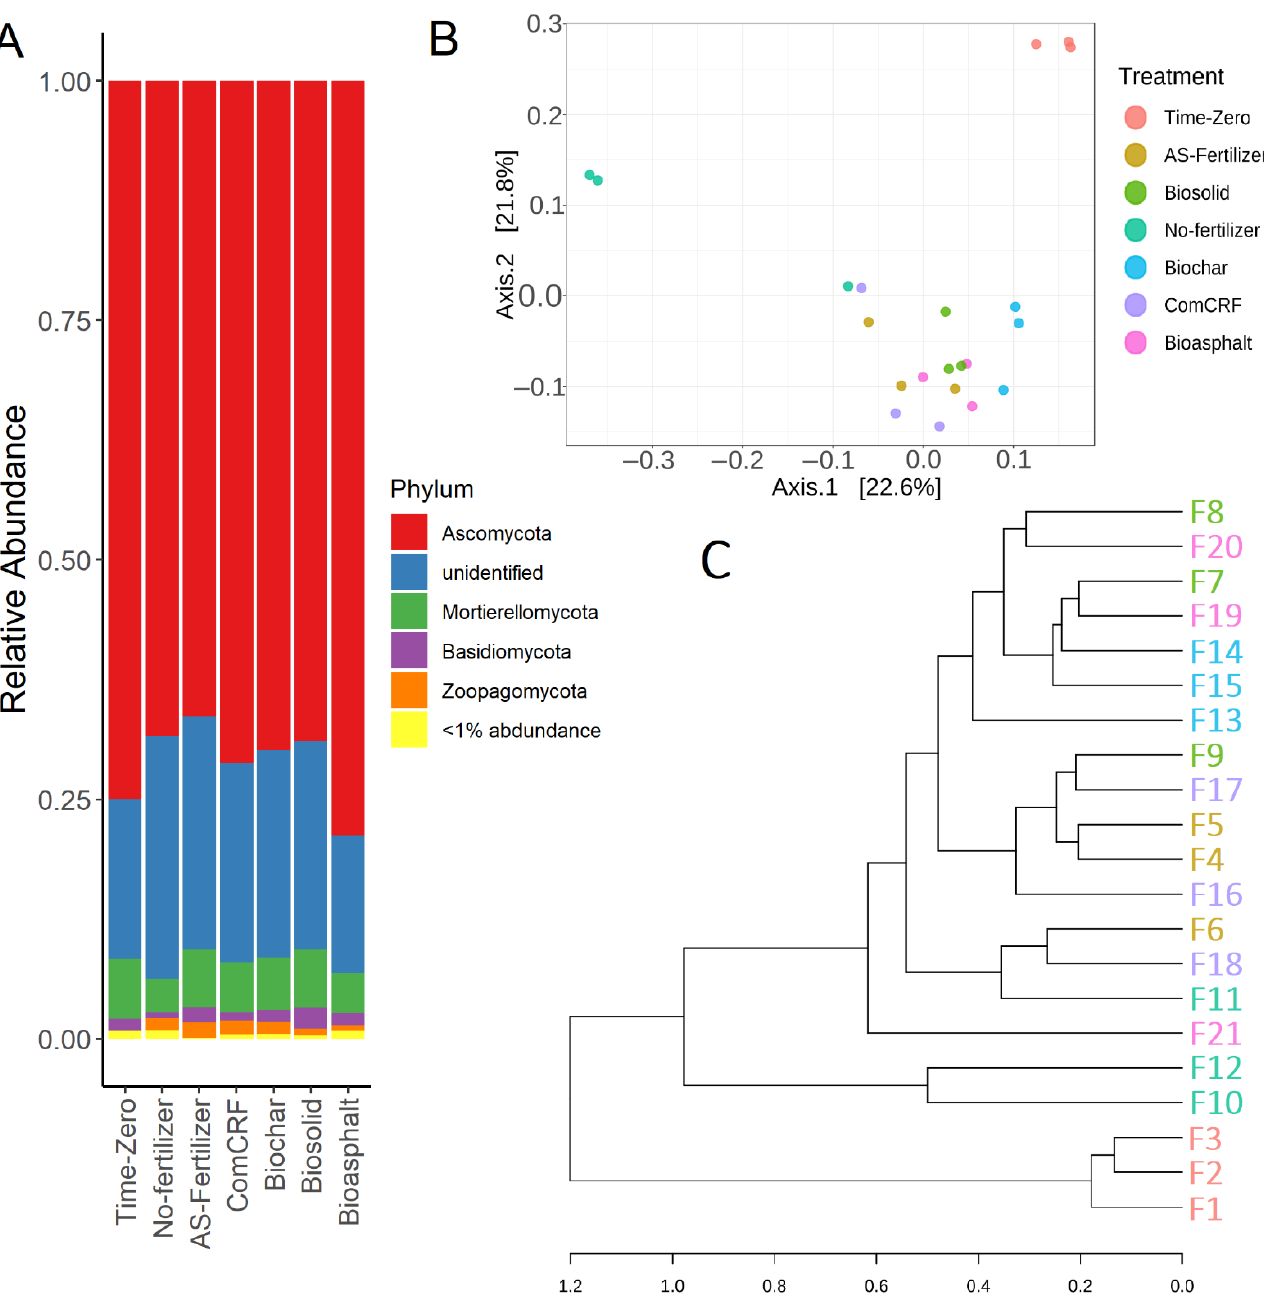
Figure 2. The fungal community in soil at phylum level ( A ), Beta-diversity [PERMANOVA] F-value: 2.7183; R-squared: 0.5381; p -value < 0.001 ( B ), and hierarchical clustering using “ Ward ” clustering algorithm and Bray – Curtis Index as distance measure ( C ).